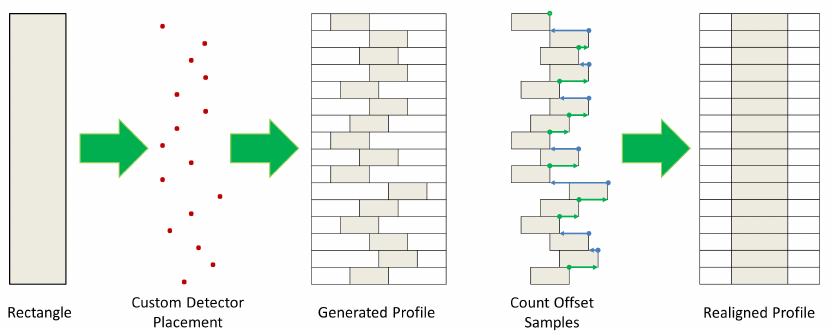
Figure 5. Vertically straight rectangle passing through custom array N-IR profiling sensor before and after realignment